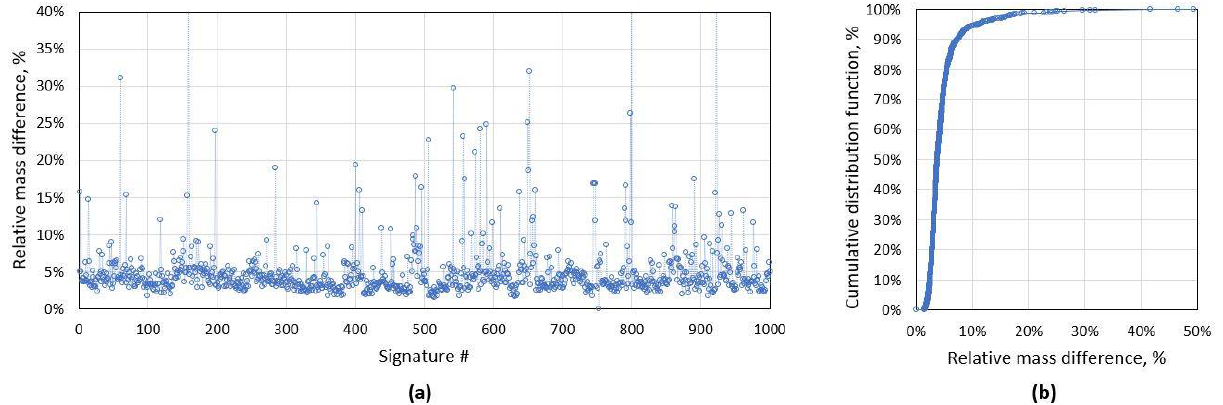
Figure 5. ( a ) The mismatch criteria distribution for the whole dataset of 1000 signatures and ( b ) cumulative distribution function (CDF) for the same data. The average mismatch between two aligned curves is 5%, and 95% of all cases have criterion below 10%.